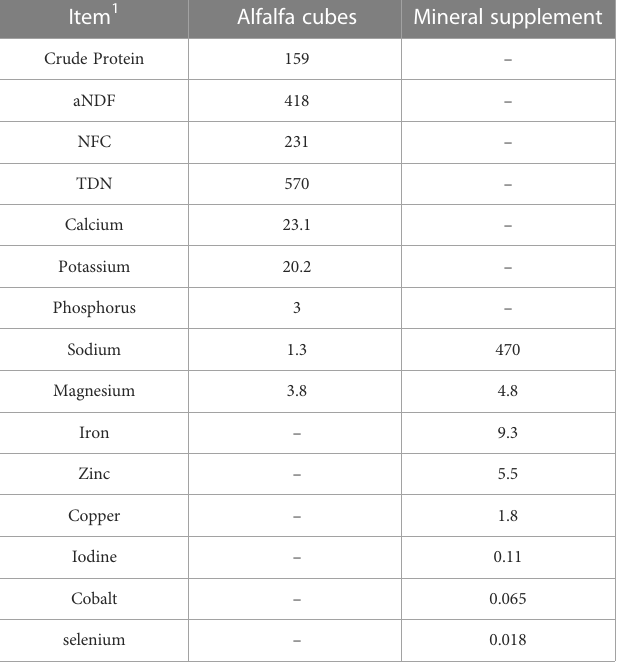
TABLE 1 Chemical composition (g/kg) of the diet fed to steers dosed abomasally with levodopa (L-DOPA). Item